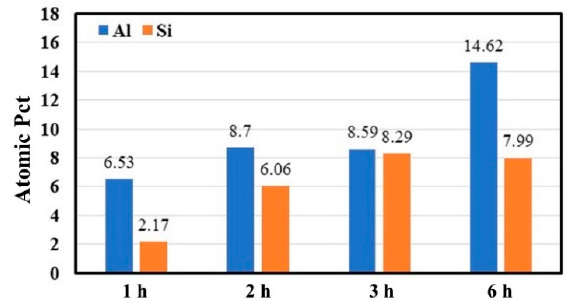
Figure 12. Comparison of elemental atomic percent in the synthesized metal from the pellet (C/O = 2) after heating at 1550 °C for 1, 2, 3, and 6 h.